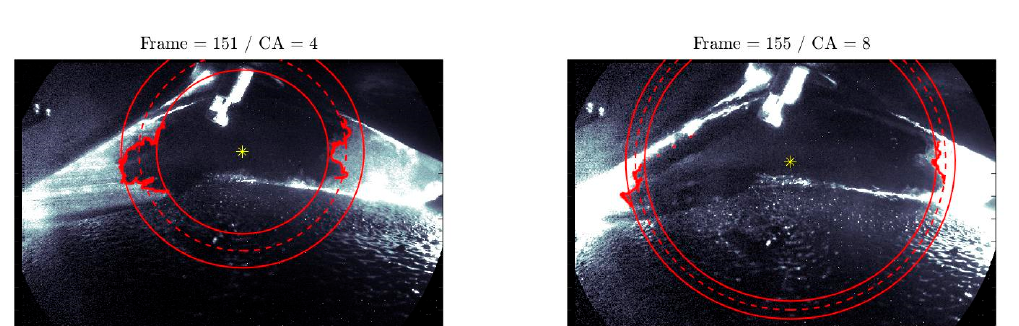
Figure 12. Cycle 58. Background corrected images of turbulent flame from 1 to 8 CAD after TDC firing. Superimposed geometric properties: flame edges, flame center, min, max, and average radii. Engine operation: 1000 RPM, wide open throttle.